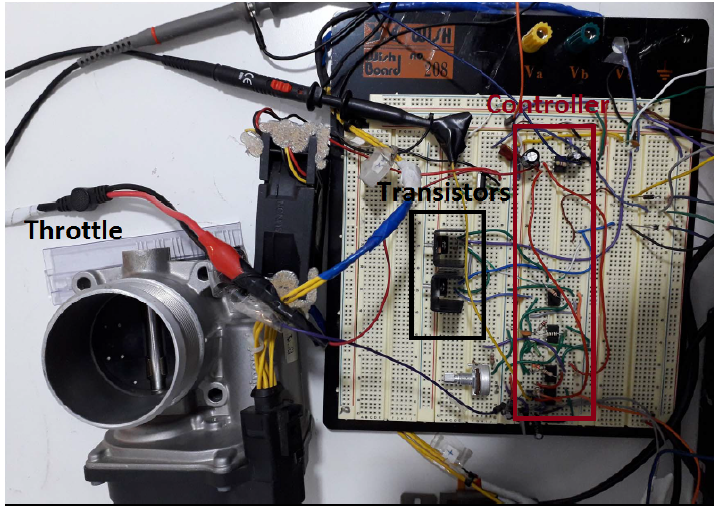
Figure 4. A photo of the designed experimental platform. The power transistors and the controller analog circuit, as can be observed, are easily to realize. This evidences its low cost implementation